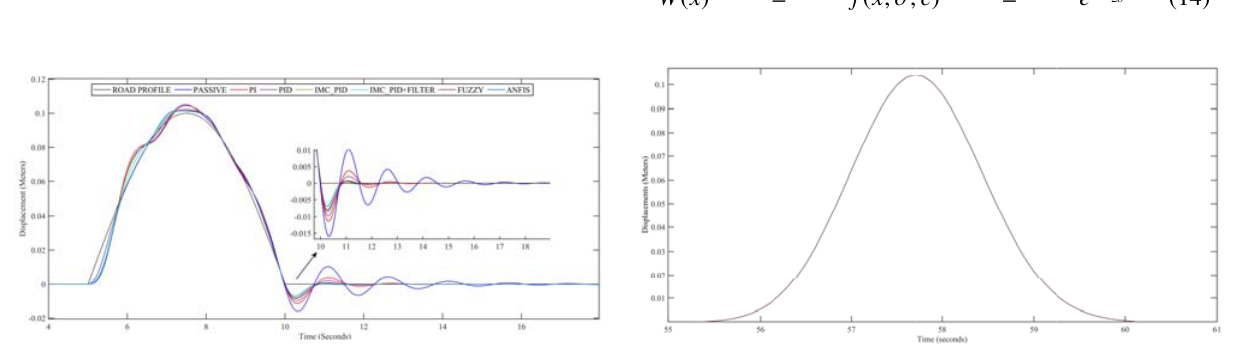
Figure 12. Response against Road profile 1a